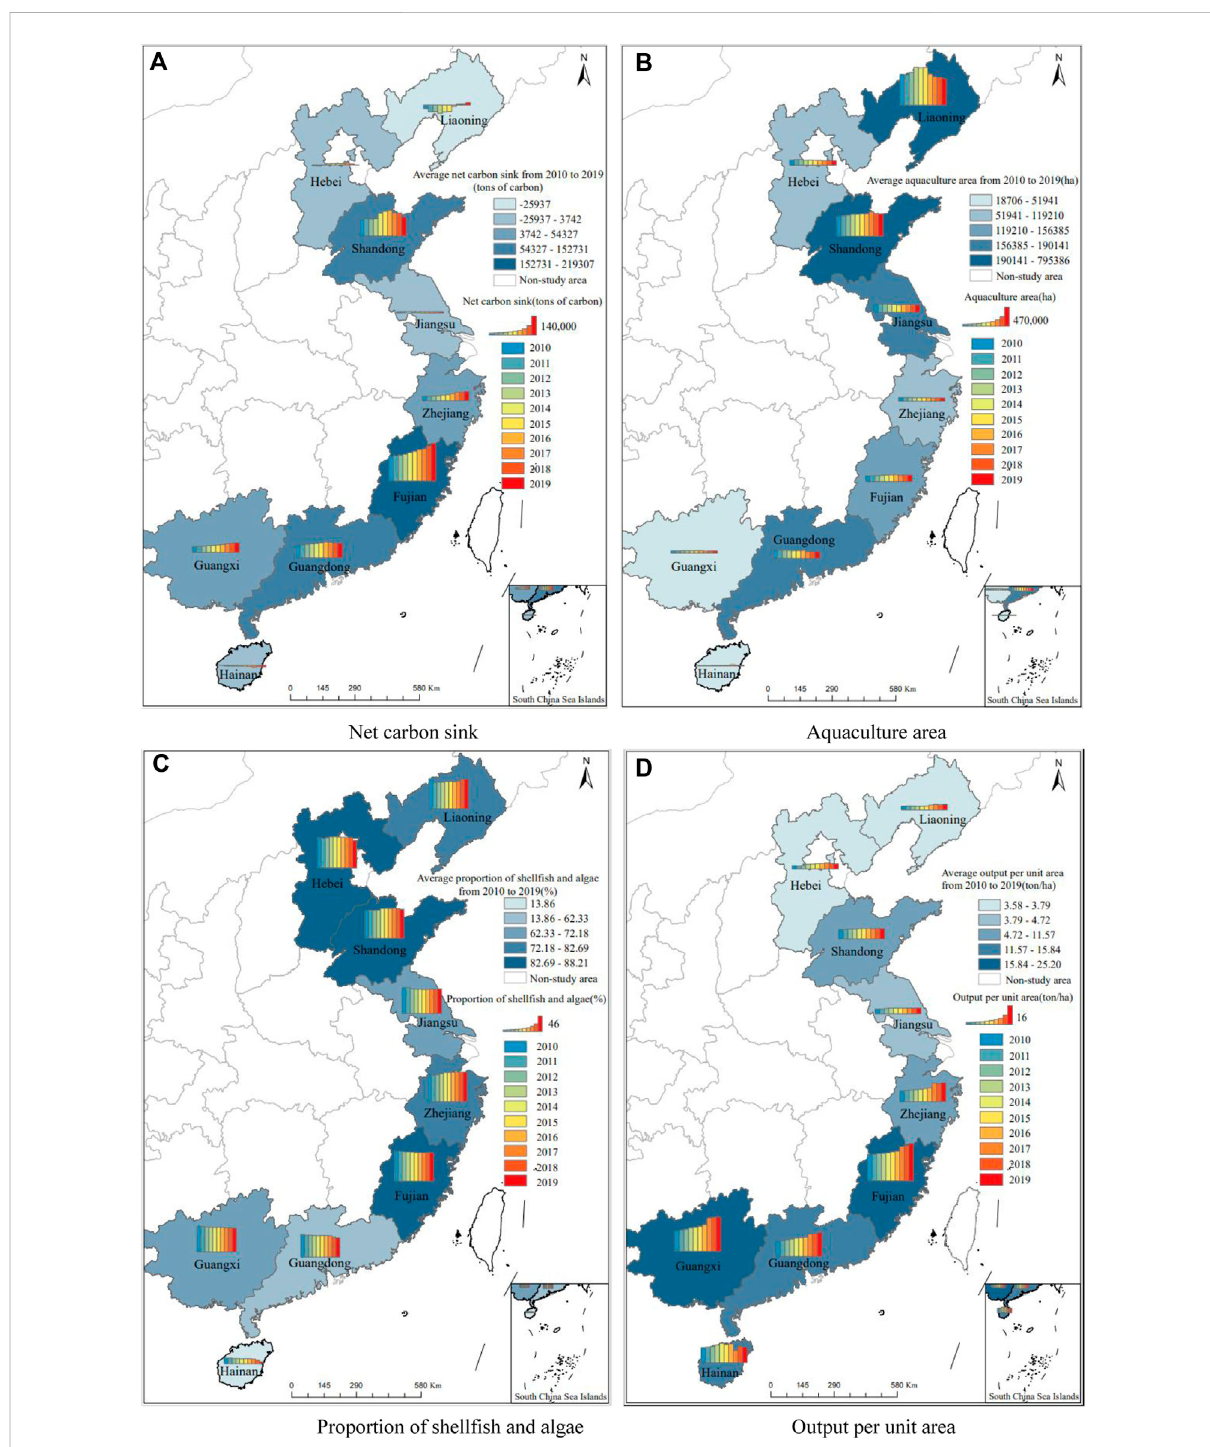
FIGURE 2 Spatio-temporal distribution map of marine aquaculture in China. Note: This map is drawn according to the standard map of the National Surveying and Mapping Geographic Information Bureau (No. GS(2019)1825), and the base map has not been modi fi ed. (A) Net carbon sink (B) Aquaculture area. (C) Proportion of shell fi sh and algae (D) Output per unit